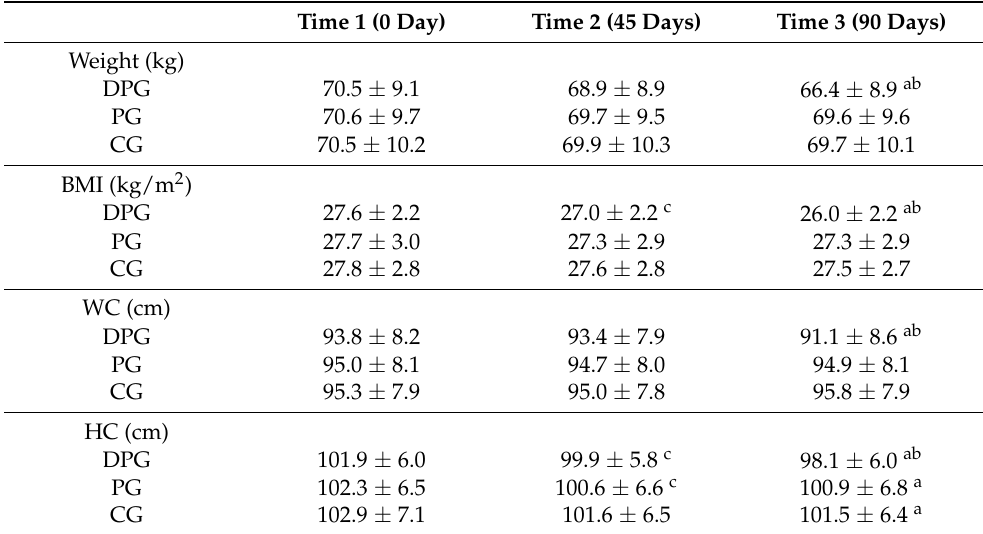
Table 2. Weight outcomes at three different time of completed cases ( n = 642), mean ±